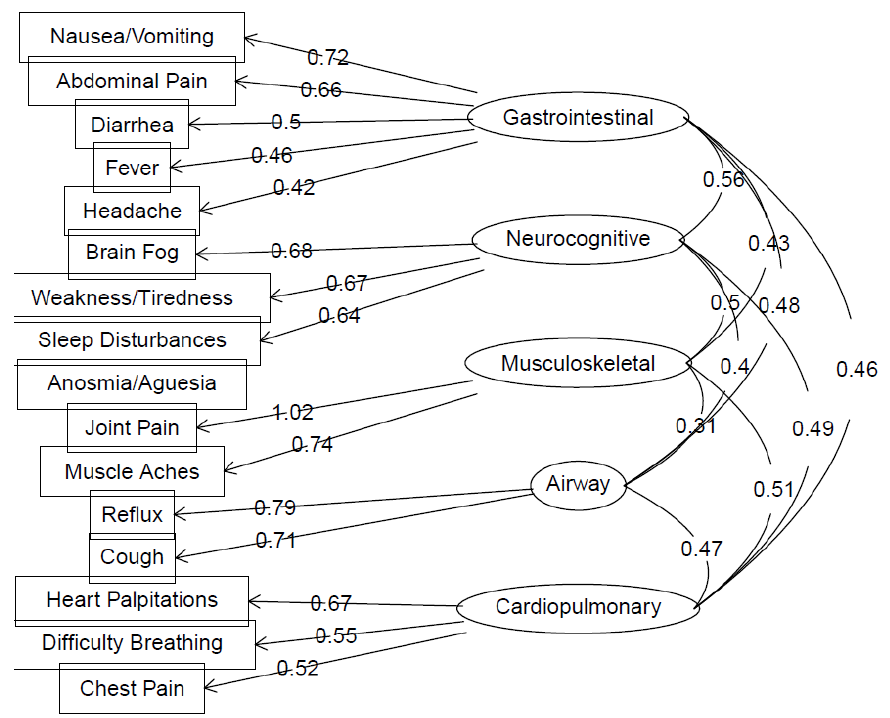
Figure 2. Factor loadings and intercorrelations obtained from exploratory factor analysis of Long COVID symptom frequency (16 items). Loadings are based on oblimin rotated solution of polychoric correlation matrix. Only loadings >0.40 are shown. Table 2. Sociodemographic and clinical predictors of symptom clusters.